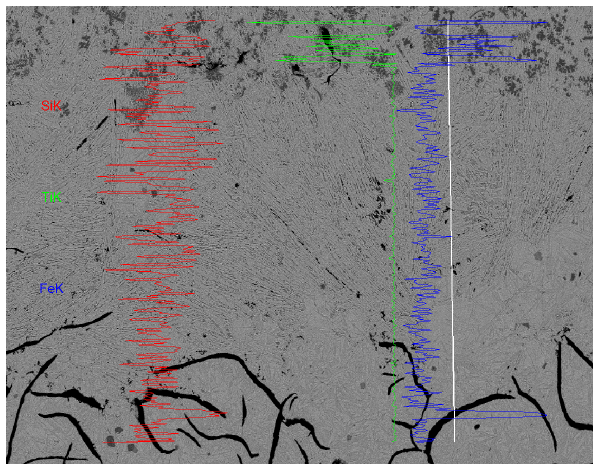
Figure 7. The results and the diagram of the EDS line analysis at the transition zone.